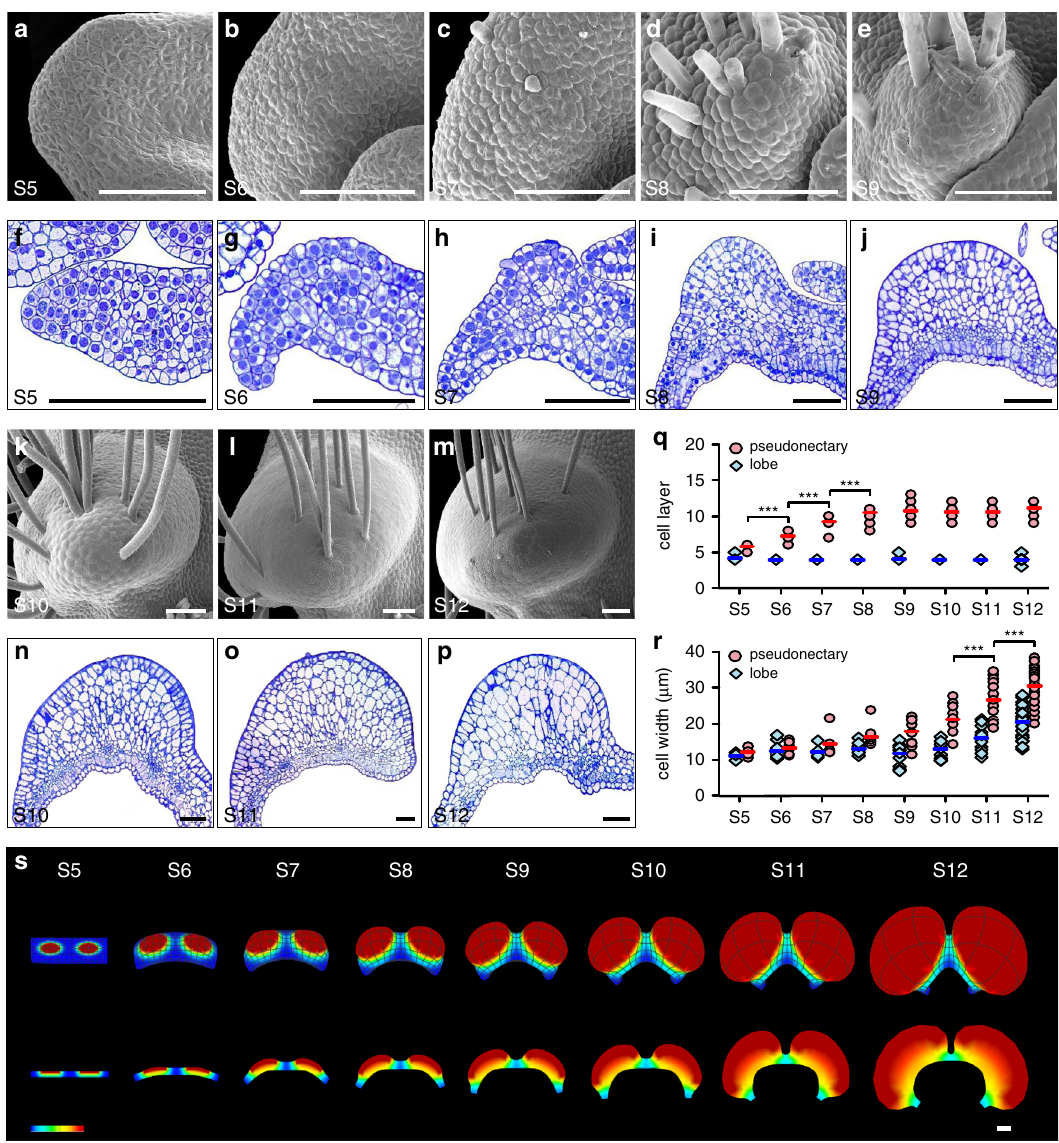
Fig. 3 The pseudonectary development. Pseudonectaries at various developmental stages under SEM ( a – e , k – m ), with their corresponding transverse semi-thin sections being shown in ( f – j , n – p ). Scale bars: 100 μ m. Comparisons of cell layer ( q ) and cell width ( r ) between the pseudonectary and lobe areas of petals at different stages. Bars indicate the mean values. The asterisks indicate the signi fi cant difference between adjacent stages by two-side Wilcoxon rank sum test ( P < 0.001). The exact P values were listed in the Source Data. In q , n = 10 for S5, n = 19 for S6, n = 14 for S7, n = 16 for S8, n = 18 for S9, n = 10 for S10, n = 18 for S11, and n = 37 for S12; In r , n = 24 cells for S5, n = 42 cells for S6, n = 15 cells for S7, n = 33 cells for S8, n = 39 cells for S9, n = 30 cells for S10, n = 54 cells for S11, and n = 120 cells for S12. Source data for q and r are provided as a Source Data fi le. s Schematic of the pseudonectary development. The three-dimensional shapes and their corresponding transverse sections at S6, S7, S9, and S12 are shown, respectively. Heatmap is plotted denoting the relative growth rates. For a – p , the experiments were repeated four times independently with similar